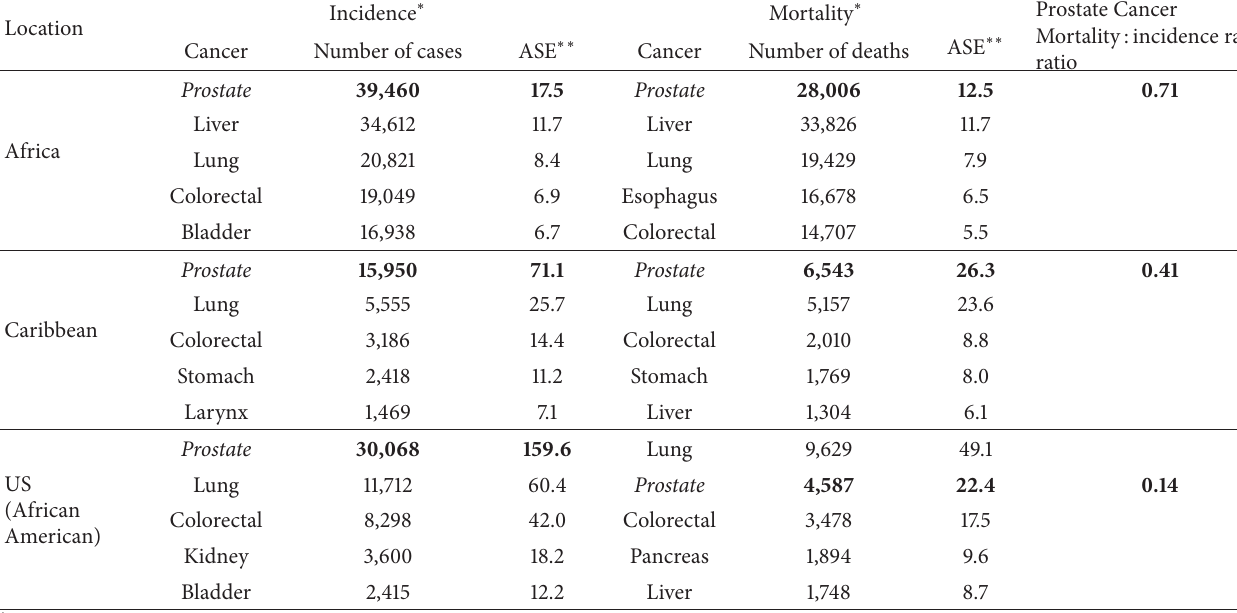
Table 1: Age-Standardized Estimates (ASE) of incidence and mortality during 2008 for five leading cancers in men of African descent by Geography.